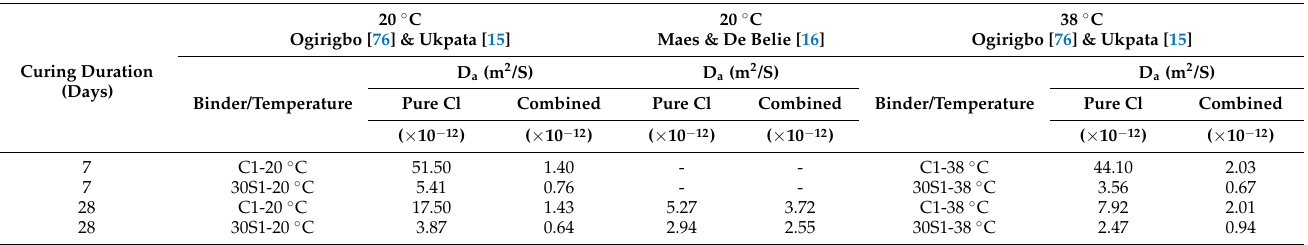
Table 4. Comparisons between chloride diffusion in mortars exposed by submersion to pure chloride and combined chloride–sulphate solutions from different authors